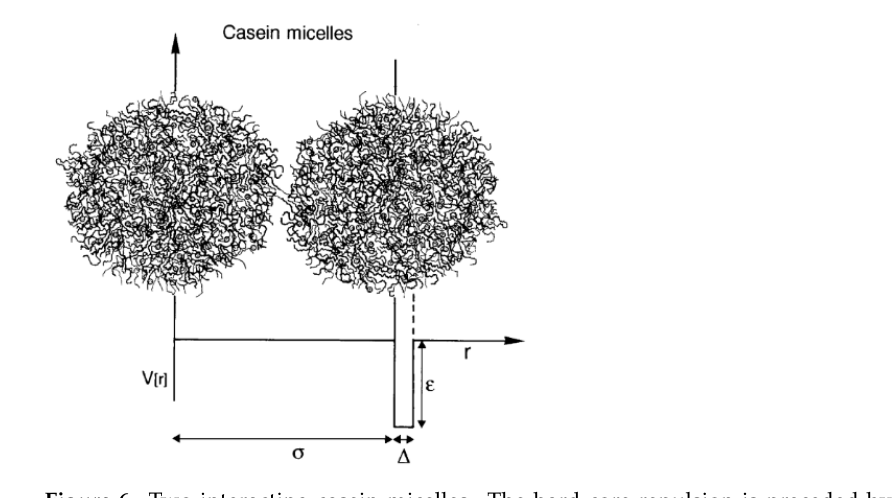
Figure 6. Two interacting casein micelles. The hard-core repulsion is preceded by an attractive interaction modeled as a “square well” potential. The depth of the well depends on the stability of the κ -casein brush. Reproduced with permission from [De Kruif, C.G.], [Casein Micelle Interactions]; published by [ Int. Dairy J. ], [1999].